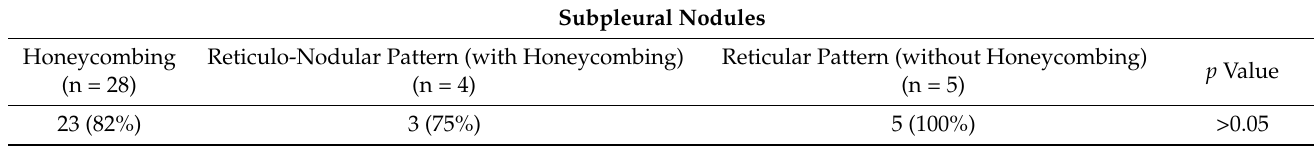
Figure 3. HRCT and TUS scan of a 54 ‐ year ‐ old woman with familiarity for pulmonary fibrosis. In ( A ), HRCT scan shows a diffuse bilateral peripheral increase in pulmonary density (ground glass opacity) with widespread parenchymal nodular lesions (maximum size: 7 mm), in greater numbers in the lower lobes. In ( B ), TUS scan with a low ‐ frequency convex probe (3.5–5 MHz) (in the chest area corresponding to the blue box in ( A ) shows a thickened pleural line (white arrow)). In ( C ), TUS scan with a high ‐ frequency linear probe (8–12.5 MHz) at the same level does not show a clearly blurred and fragmented aspect. Table 3. Presence of >3 B-lines between different degrees of fibrosis. Table 4. Presence of TUS subpleural nodules between different HRCT